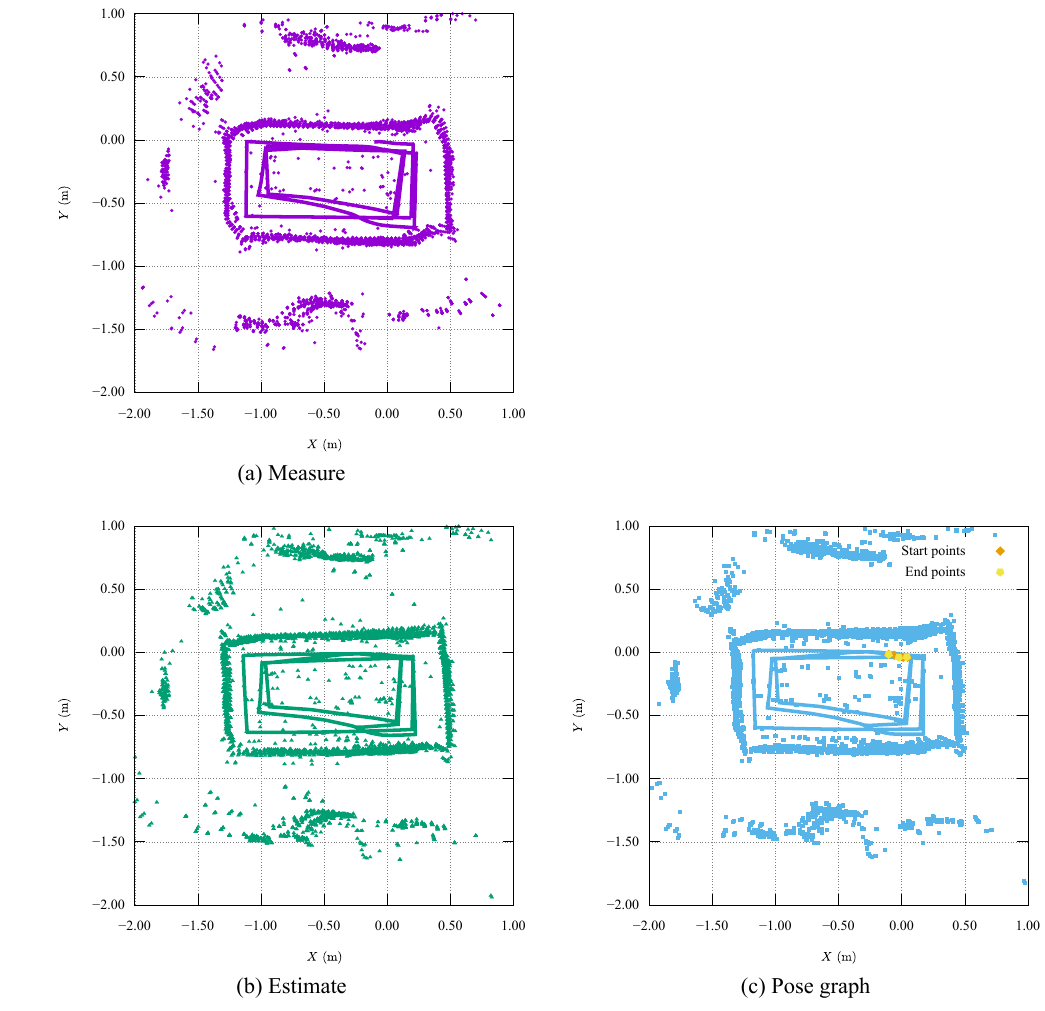
Figure 11. Robot’s trajectory and the scanned shape of the window frame. They are obtained by ( a ) measurement, ( b ) pose estimation, and ( c ) loop closure, respectively. They indicate the robot’s trajectories with lines and the positions of objects scanned by the 2D laser range scanner with dots. The shape of the rectangular window frame is described outside the robot’s trajectory by the gathered scan dots along the trajectory.